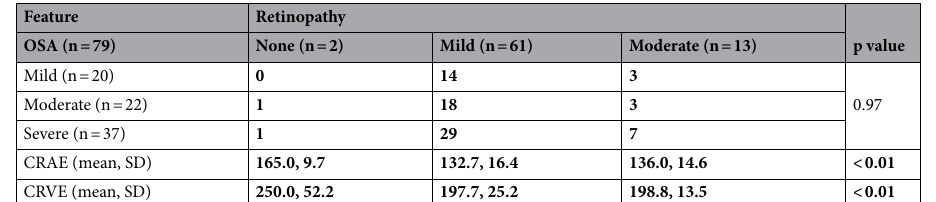
Table 2. Correlation of Microvascular retinopathy with OSA features and retinal arteriolar and venular calibre. More severe grades of OSA based on the apnoea: hypoponoea index were not associated with more severe microvascular retinopathy. However arteriolar and venular calibre were narrower with mild and moderate retinopathy compared with none. CRAE central retinal artery equivalent, CRVE central retinal vein equivalent. Significant values are in bold.